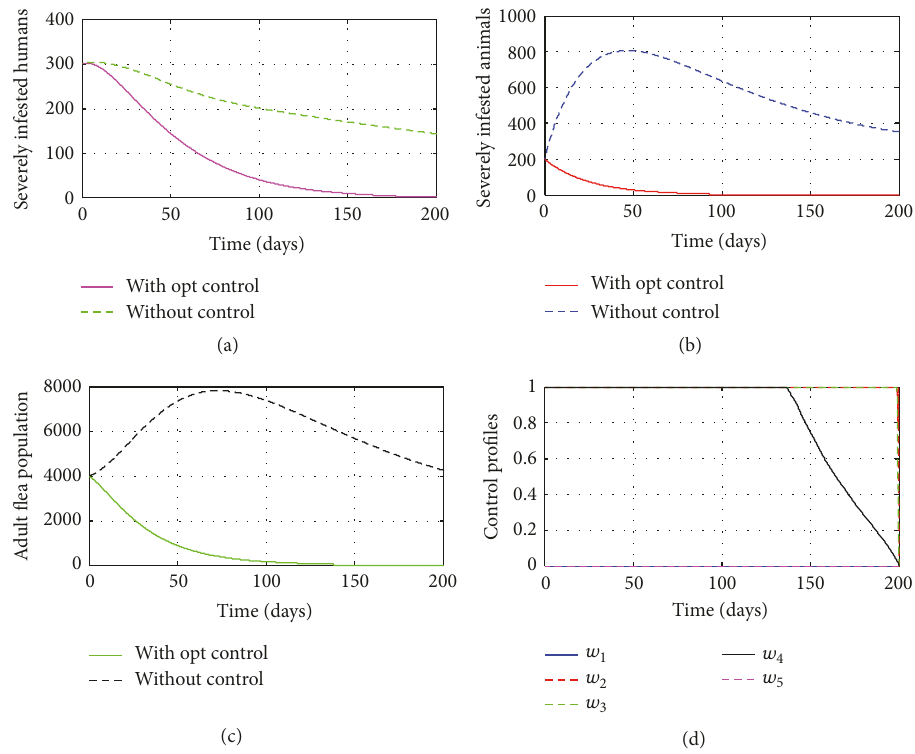
Figure 8: Optimal solutions for model variables 𝐼 𝐻ℎ , 𝐼 𝐴ℎ , 𝐹 𝐸 and the control profiles for 𝑤 1 , 𝑤 2 , 𝑤 3 , 𝑤 4 , 𝑤 5 with (𝑤 2 ,𝑤 3 , 𝑤 4 ̸= 0)